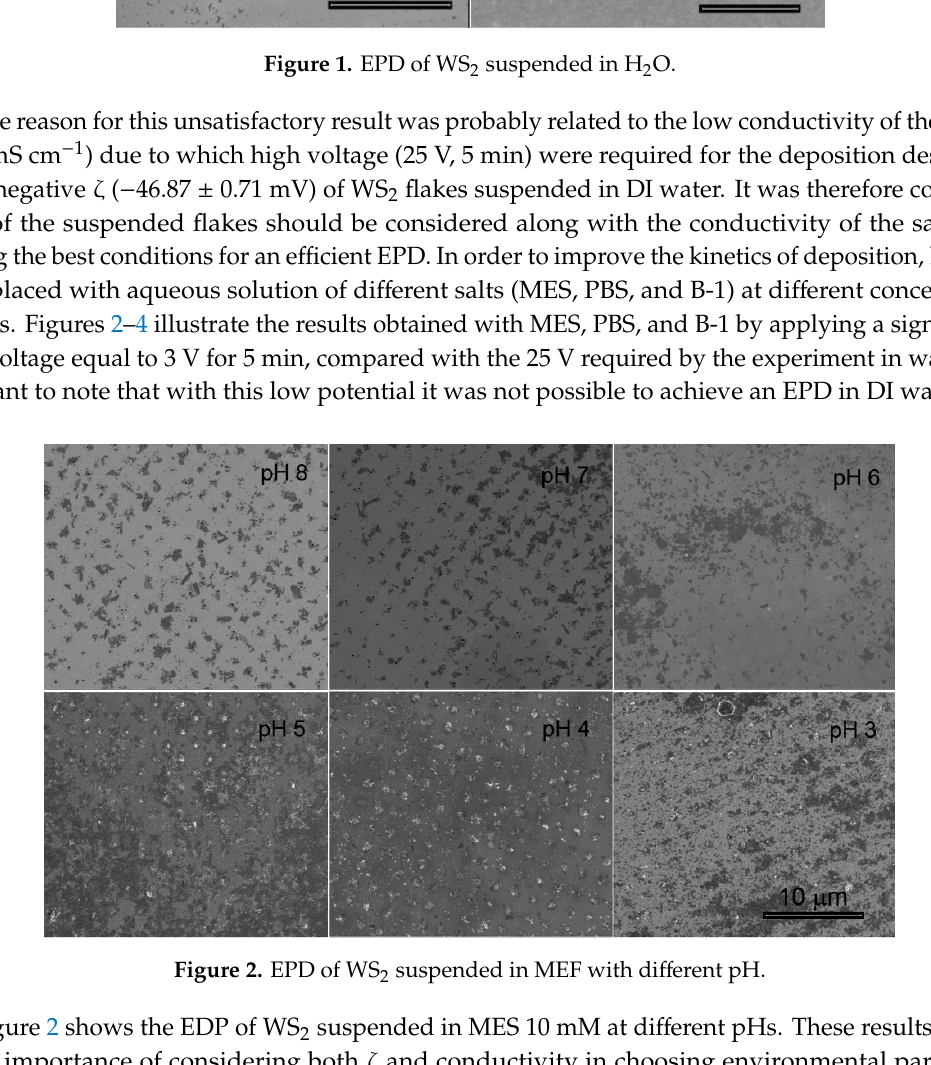
Figure 1. EPD of WS 2 suspended in H 2 O.